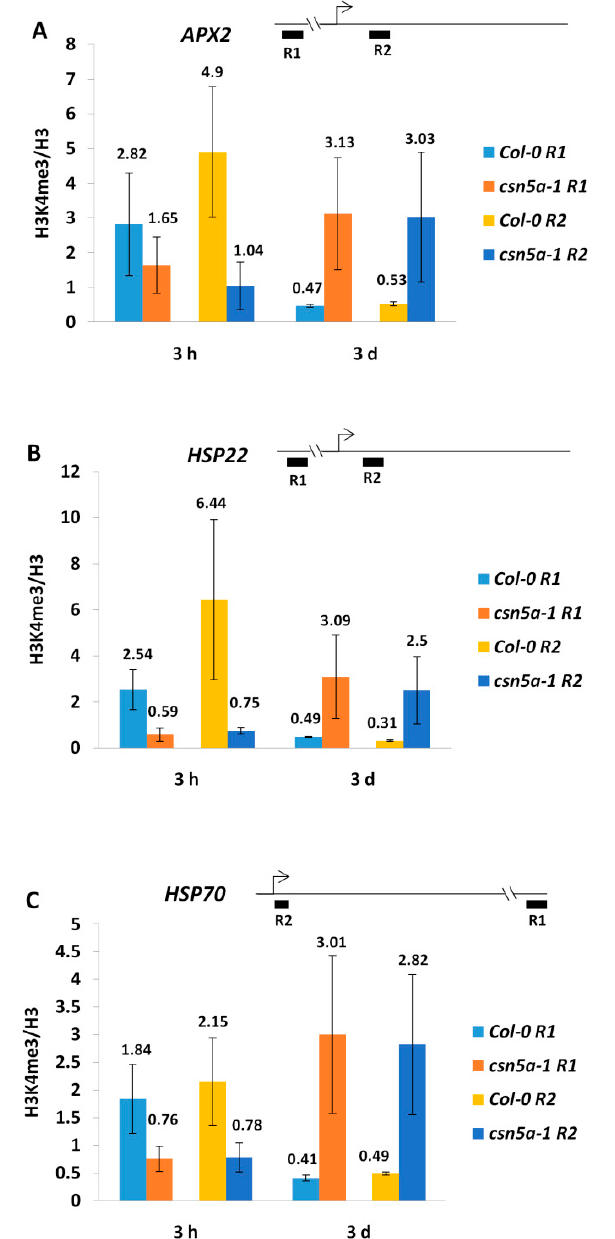
Figure 3. H3K4me3 fold change (heat stress/control) increases 3 h after recurrent heat stress in Col-0 and decreases to the baseline after 3 d; however, it is the opposite for csn5a-1. ( A ) H3K4me3 levels of APX2 3 h and 3 d after recurrent heat stress (2 h, 44 °C, 7 d) in Col-0 and csn5a-1 . ( B ) H3K4me3 levels of HSP22 3 h and 3 d after recurrent heat stress (2 h, 44 °C, 7 d) in Col-0 and csn5a-1 . ( C ) H3K4me3 levels of HSP70 3 h and 3 d after recurrent heat stress (2 h, 44 °C, 7 d) in Col-0 and csn5a-1 . ChIP-qPCR was performed with antibodies against H3K4me3 and H3 (for normalization). Amplification values were normalized with H3 and the respective non-heat stress (control) sample at the same point. Schematics show the position of the gene region analyzed. R1 is the intergenic region, 3123 bp ( APX2 ) or 2570 bp ( HSP22 ) upstream of TSS, or 6725 bp ( HSP70 ) downstream of the transcription start site (TSS). R2 is the 5’-region of APX2, HSP22 , and HSP70. Error bars represent SEM of biological replicates ( n = 3–4).